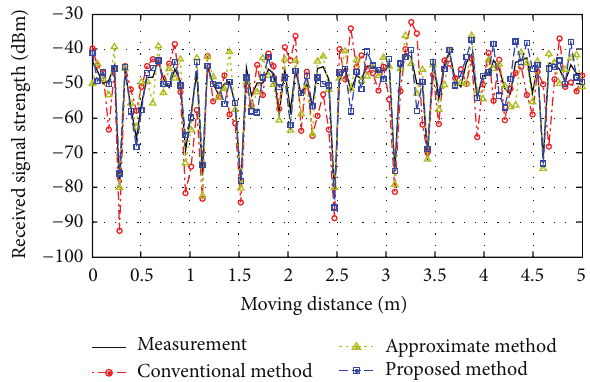
Figure 6: Comparison of fading effect along path 2 for measured and simulated results at 700 MHz.